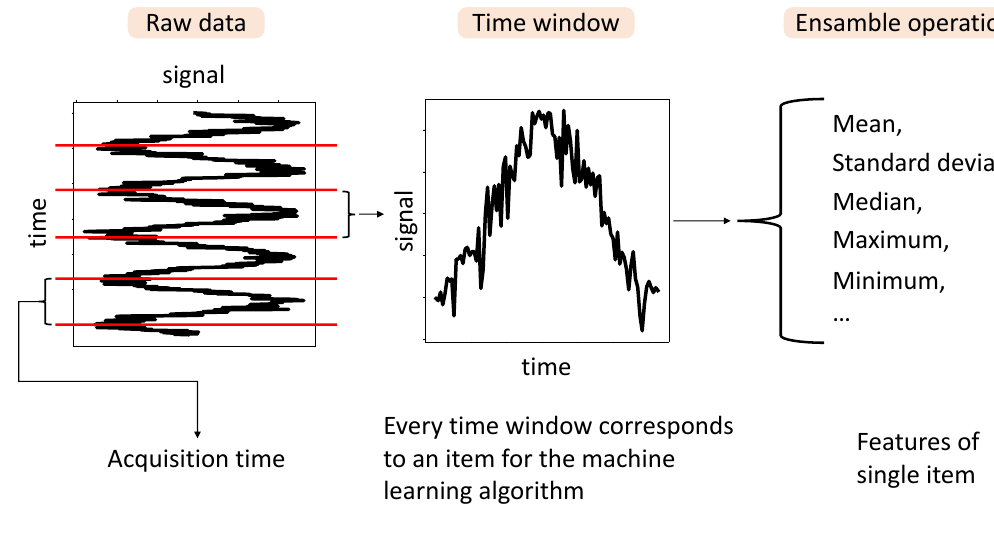
Figure 3. Data collection process for HAR dataset composition